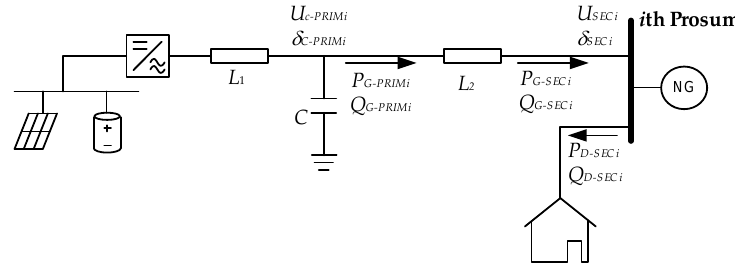
Figure 2. Converter magnitudes for primary control.